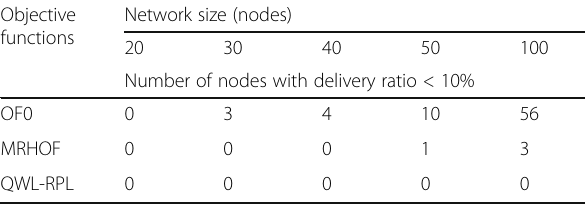
Table 4 Illustrating scenario I network imbalance with delivery ratio (%).